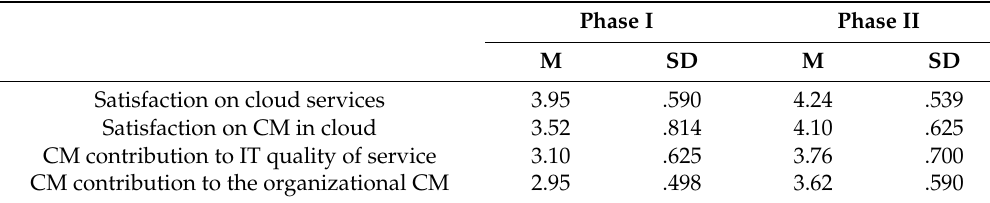
Table 7. Descriptive statistics on the compliance evaluation sheet. Inter